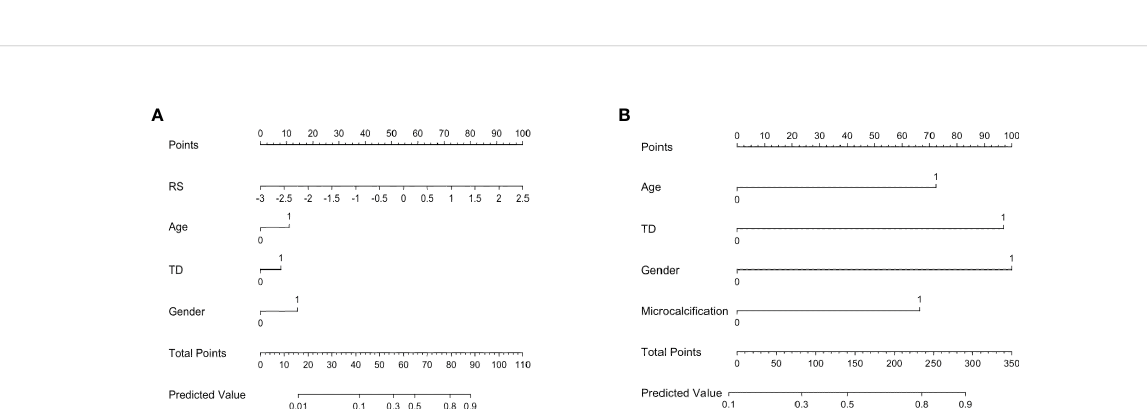
FIGURE 5 Nomogram for the RS-Clin (A) and Clin-CUS (B) model for predicting the probability of CLNM. RS, radiomics scores; Age 0: age ≥ 41y, 1: age < 41y; TD, tumor diameter 0: TD < 0.9cm, 1: TD ≥ 0.9cm; Gender 0: Female, 1: Male; Microcalci fi cation 0: No/macrocalci fi cation, 1: microcalci fi cation; RS-Clin, radiomics scores + Clinical features; Clin-CUS, Clinical features + CUS